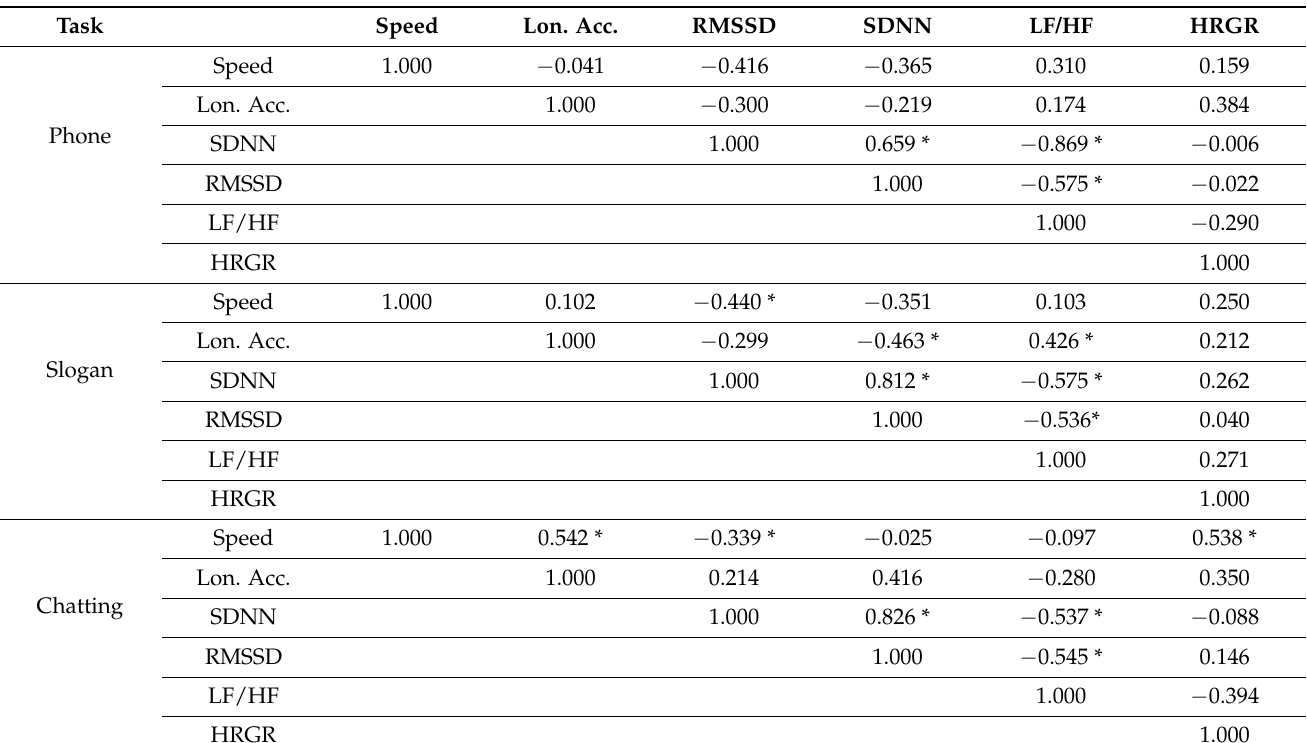
Figure 12. HRGR difference in gender during tasks: ( a ) Hands-free phone conversation; ( b ) slogan reading.